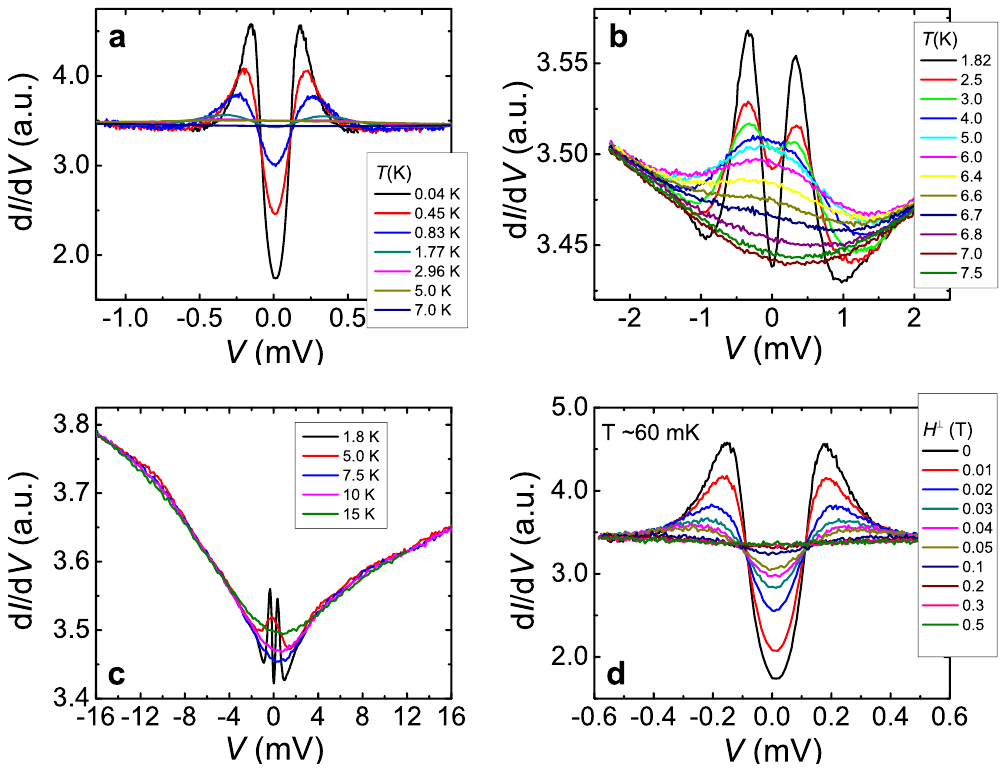
Figure 3. Point contact spectra of a NbSe 2 /16 QL Bi 2 Se 3 heterostructure. ( a ) From 0.04 K to 7.0 K. ( b ) From 1.8 K to 7.5 K. ( c ) Conductance spectra to high V bias at temperatures 1.8 K, 5.0 K, 7.5 K, 10 K, and 15 K, respectively. ( d ) Conductance spectra at different magnetic fields. The sample temperature is at ~60 mK. The contact normal resistance R n is 57